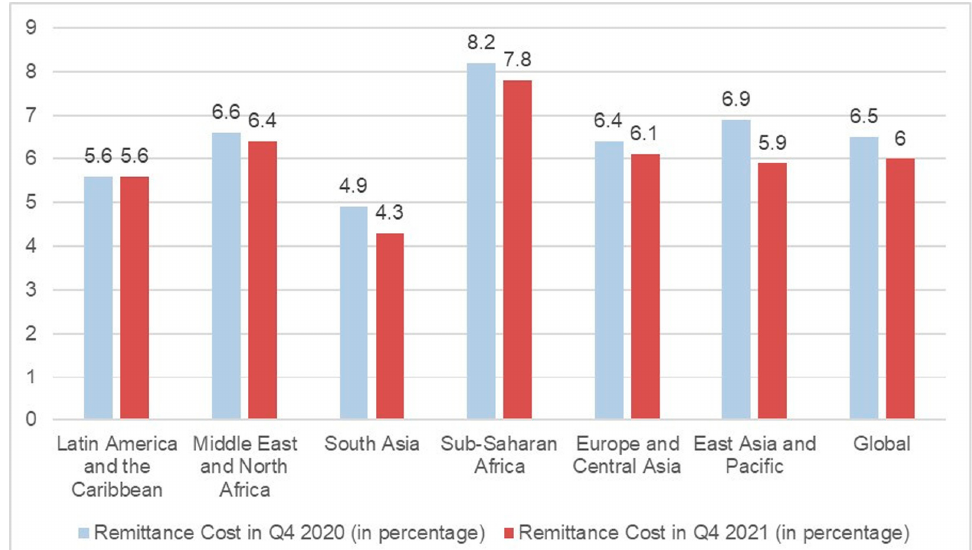
Figure 6. Remittance costs Q4 2020–21.